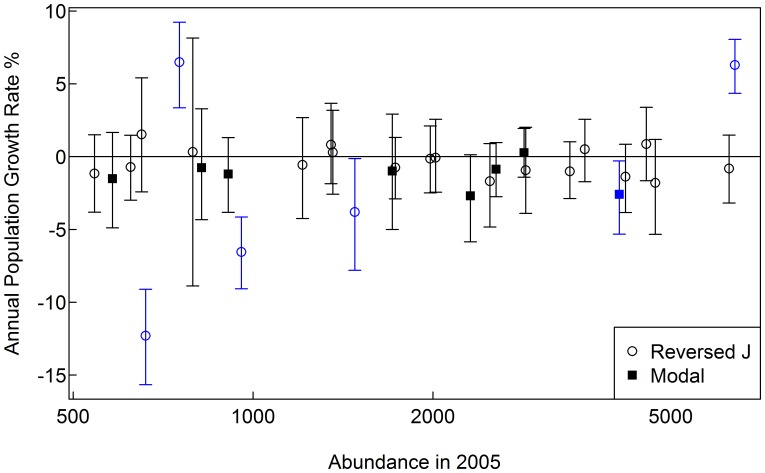
Annual per capita population growth rates of the focal species.Vertical bars denote the 95% confidence interval from 1000 bootstraps over 20×20 quadrats. Blue highlights changes that are significantly different from zero.